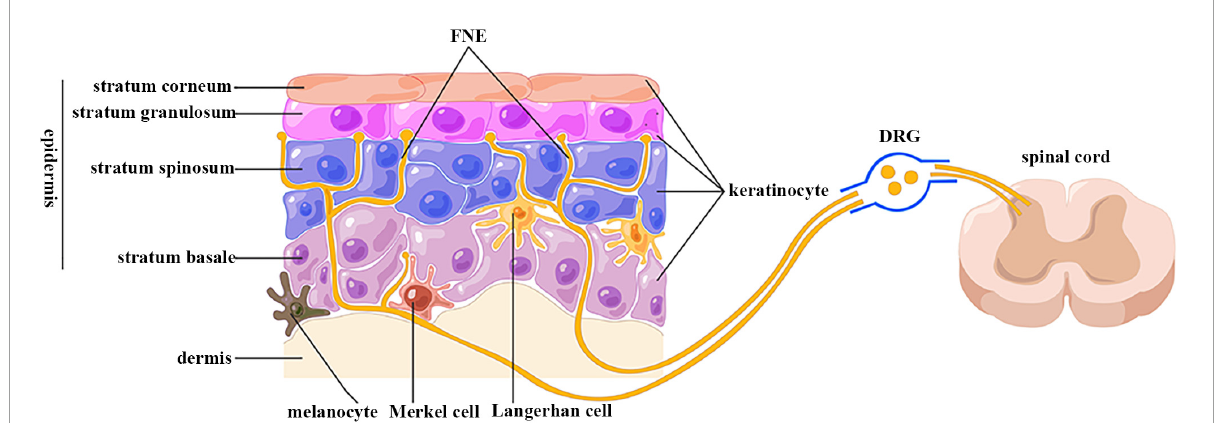
FIGURE1 Anatomical relationship between keratinocytes and sensory nerve endings. FNE, free nerve ending; DRG, dorsal root ganglion. Epidermis is divided into four layers: stratum basale, spinosum, granulosum, and corneum. Keratinocytes are the predominant cells in epidermis. The epidermis is highly innervated with intraepidermal free nerve endings, which are enwrapped but also ensheathed by keratinocyte cytoplasm. Their cell bodies are located in dorsal root ganglion, and are centrally projected to spinal cord dorsal horn. (By